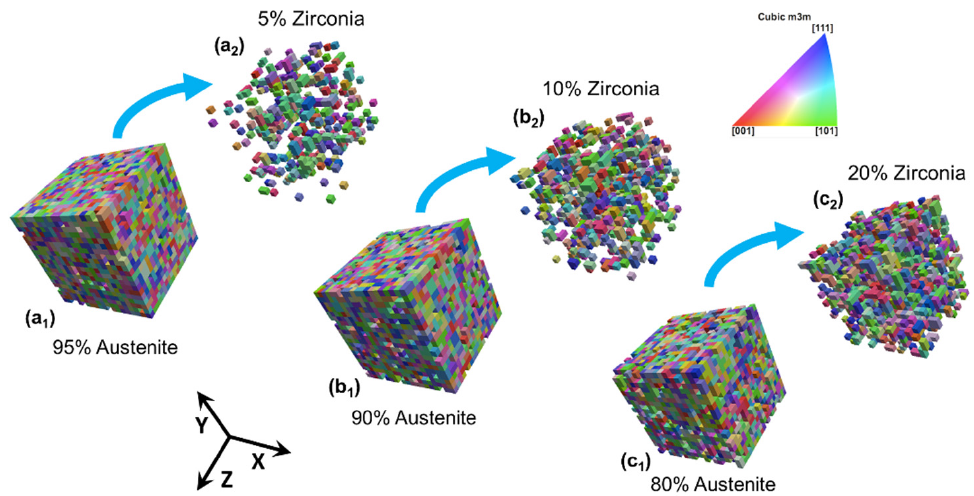
Figure 3. A multiphase RVE was generated in Dream.3D for composite, ( a 1 , b 1 , c 1 ) corresponding austenite matrix ( a 2 ) 5% zirconia particles, ( b 2 ) 10% zirconia particles, and ( c 2 ) 20% zirconia particles. Each color represents a separate grain with orientation assigned according to the given IPF legend.